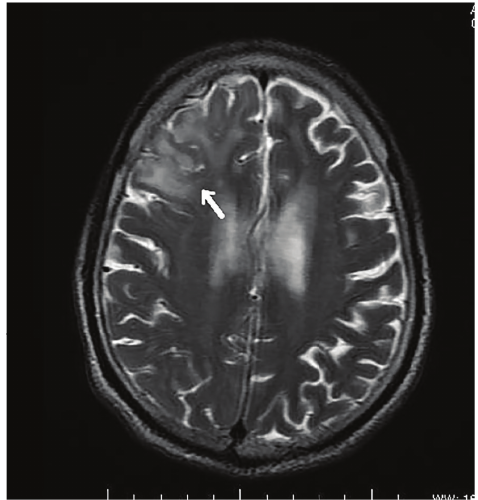
Figure 3: Axial T2 weighted image revealing cortical-subcortical hyperintensity involving the right frontal lobe (white